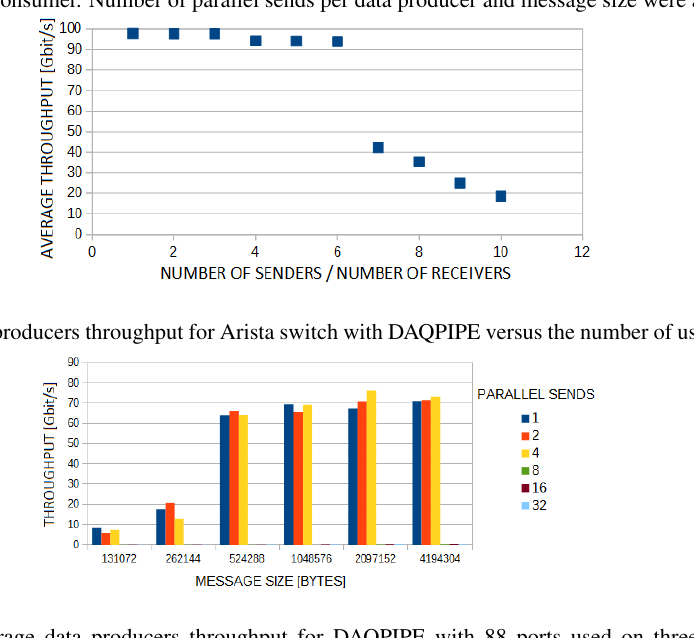
Figure 5. Average data producers throughput for DAQPIPE with 88 ports used on three Juniper QFX10000-30C line